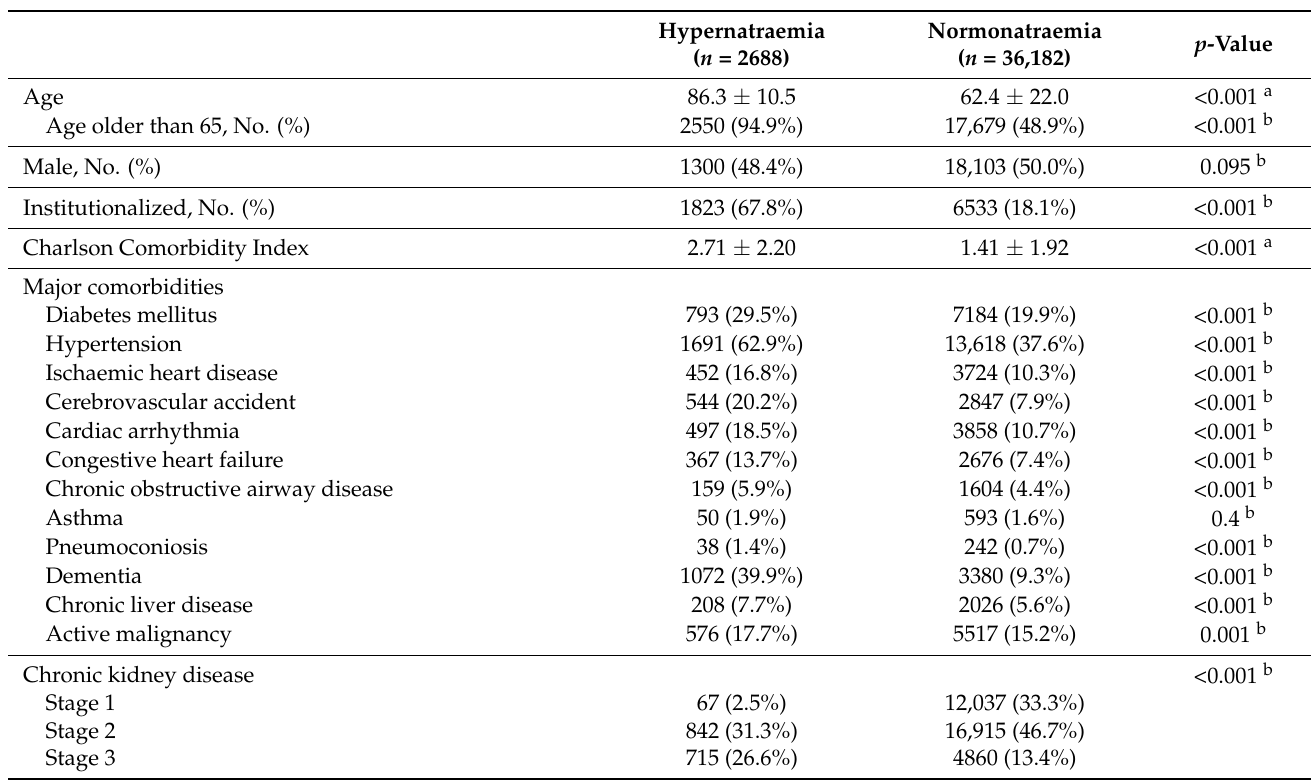
Figure 1. Disposition of patients with COVID-19 and the relationship with blood sodium levels. Table 3. Clinical characteristics of COVID-19 patients with hypernatraemia or normonatraemia at presentation.